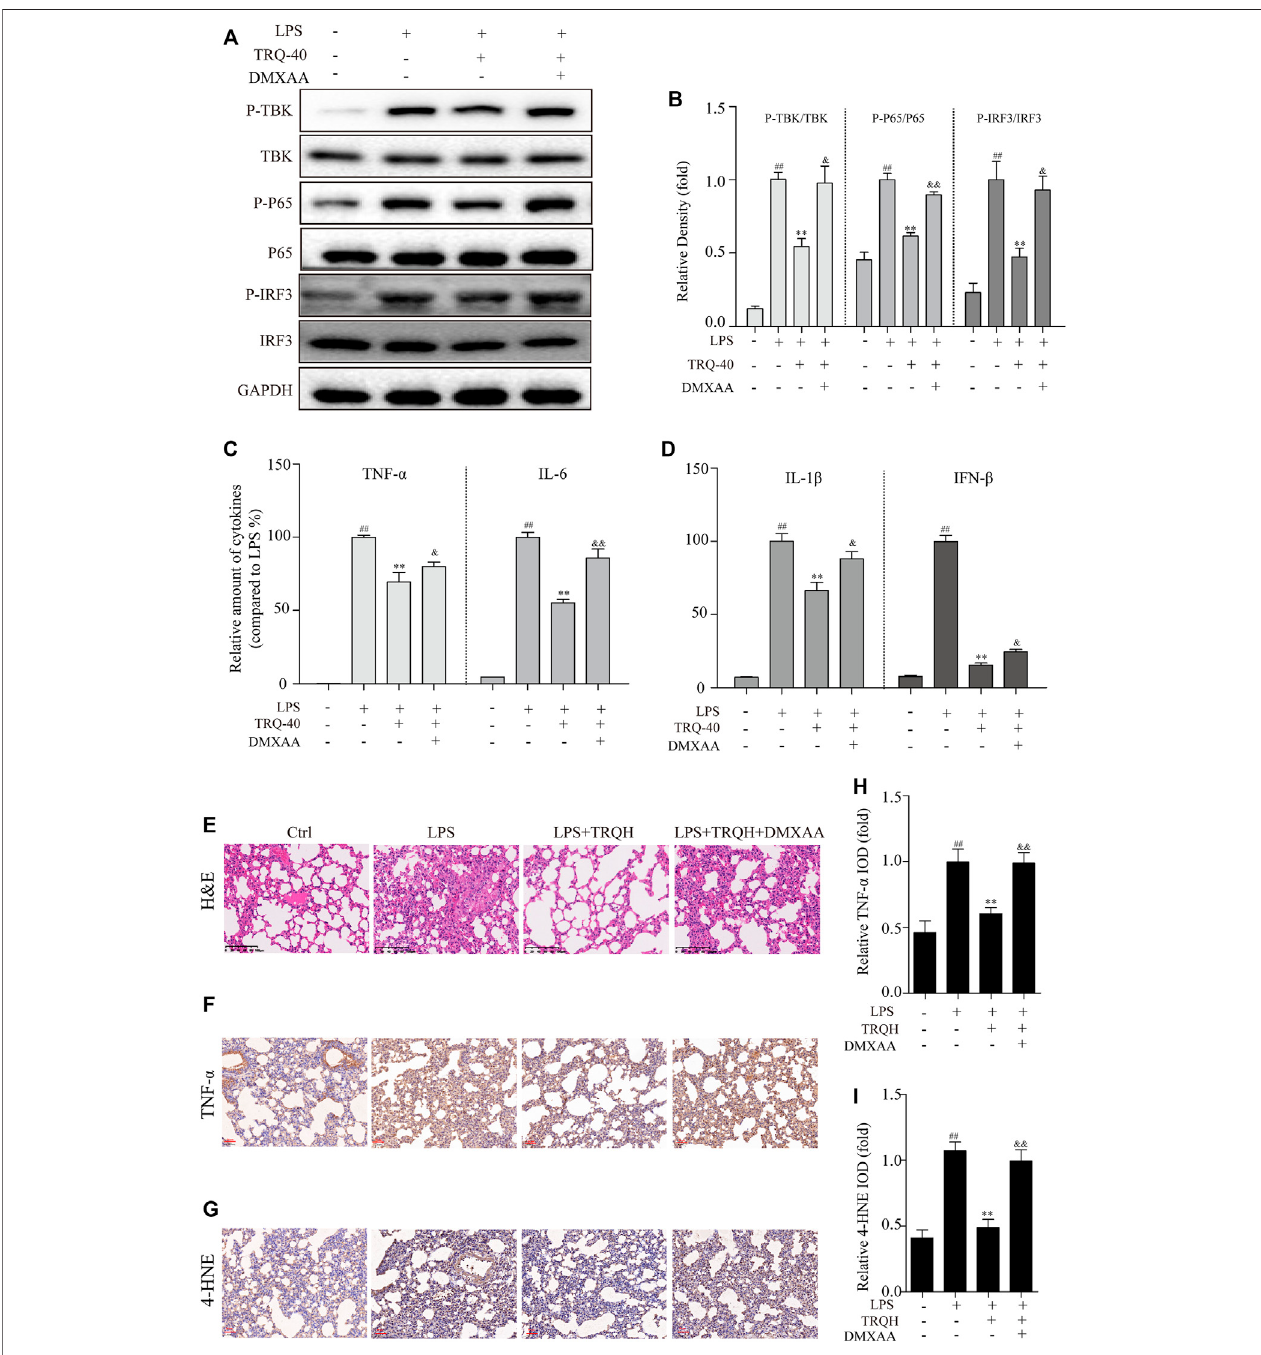
FIGURE9| TRQmightpreventacutelunginjury(ALI)bysuppressingSTINGsignalingpathway. (A – B) TherepresentativeWesternblottingmeasurementofP-TBK, TBK, P-P65, P65, P-IRF3, and IRF3 in RAW 264.7 cells. n (cid:2) 3. (C – D) The expression of TNF- α , IL-6, IL-1 β , and IFN- β in RAW 264.7 cells. n (cid:2) 5. (E) Representative images of H&E staining in lung tissues. n (cid:2) 5. (F – I) The representative images and quantitative analysis of TNF- α and 4-HNE in lung tissues. n (cid:2) 5. ## p < 0.01 vs. Ctrl group; ** p < 0.01 vs. LPS group; & p < 0.05 and && p < 0.01 vs. LPS + TRQH group, respectively.